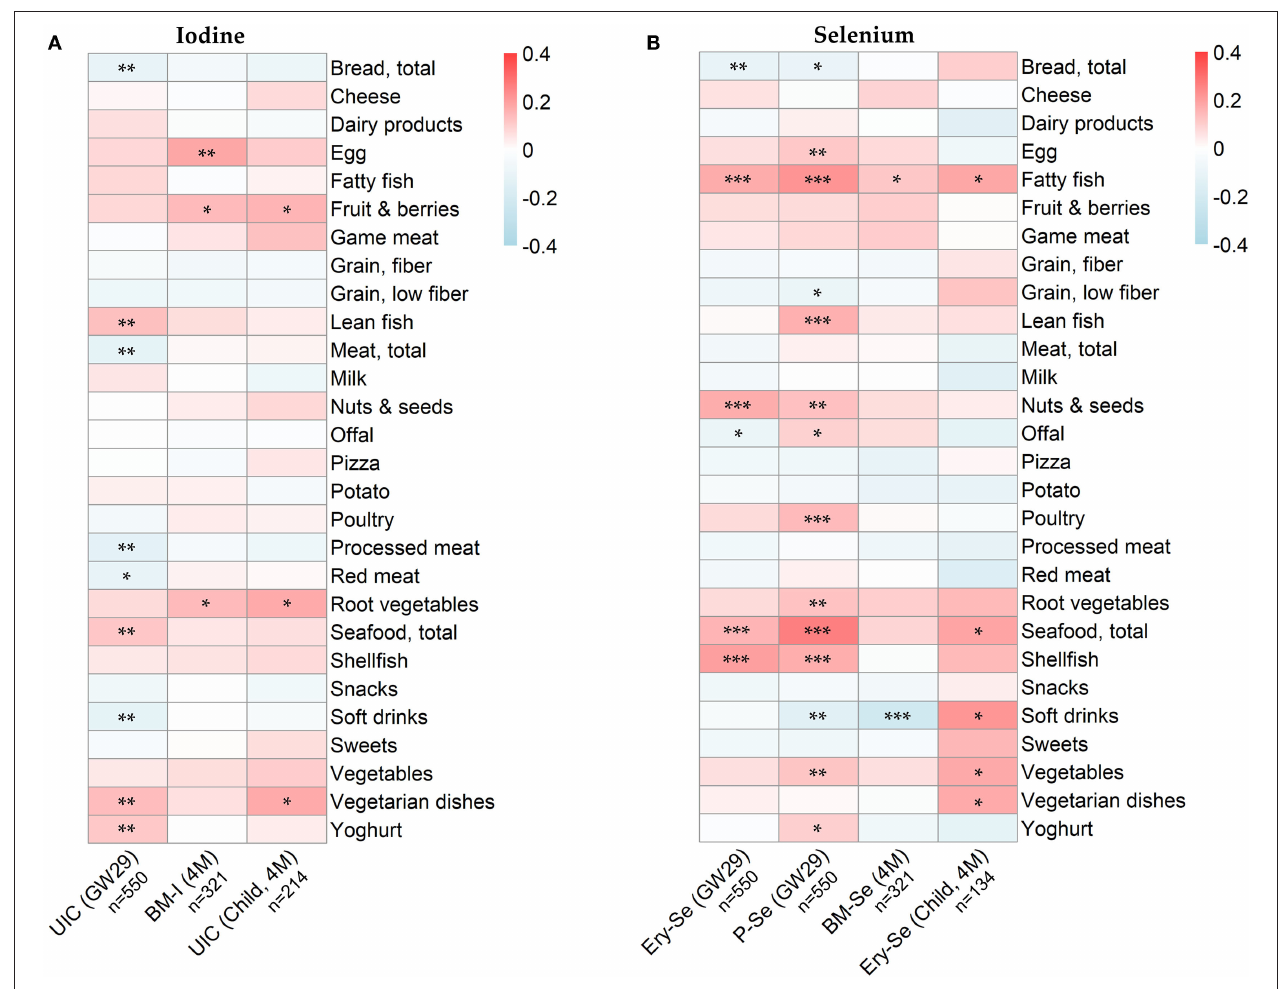
FIGURE 4 | Heatmaps displaying Spearman correlations between (A) iodine concentrations in urine (UIC) and breast milk (BM-I), and maternal food intake (B) selenium concentrations in erythrocytes (Ery-Se), plasma (P-Se) and breast milk (BM-Se), and maternal food intake. Food intake was assessed to reflect maternal intake in gestational week 30–34 and at 3–4 months postpartum. Associations between infants’ iodine and selenium concentrations and maternal food intake was investigated solely for breastfed infants (i.e., with available breast milk samples). Significant correlations are denoted with asterisks as follows: p < 0.001 = *** , p < 0.01 = ** and p < 0.05 = *